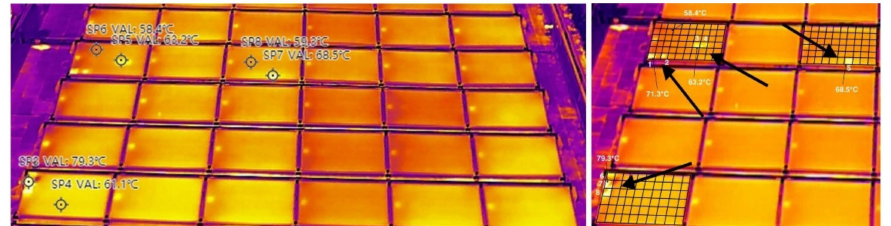
Figure 9. Hot spots indicating solar cell anomalies in the faulty panels (left side). Grid analysis on thermal images reveals the faulty cells as brighter spots in the visual spectrum (right side). There are reported temperature values of the solar cells between 55.6 (SP2) and 79.3 ◦ C (SP3), as indicated in Table 2. Table 2. Temperature measurements on different points of the PV systems.